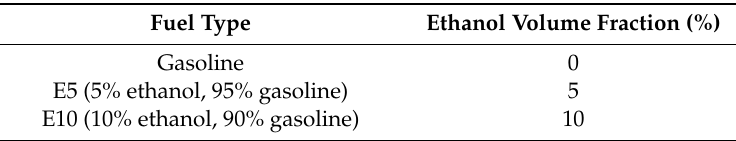
Table 2. The specification of fuels used in this study.